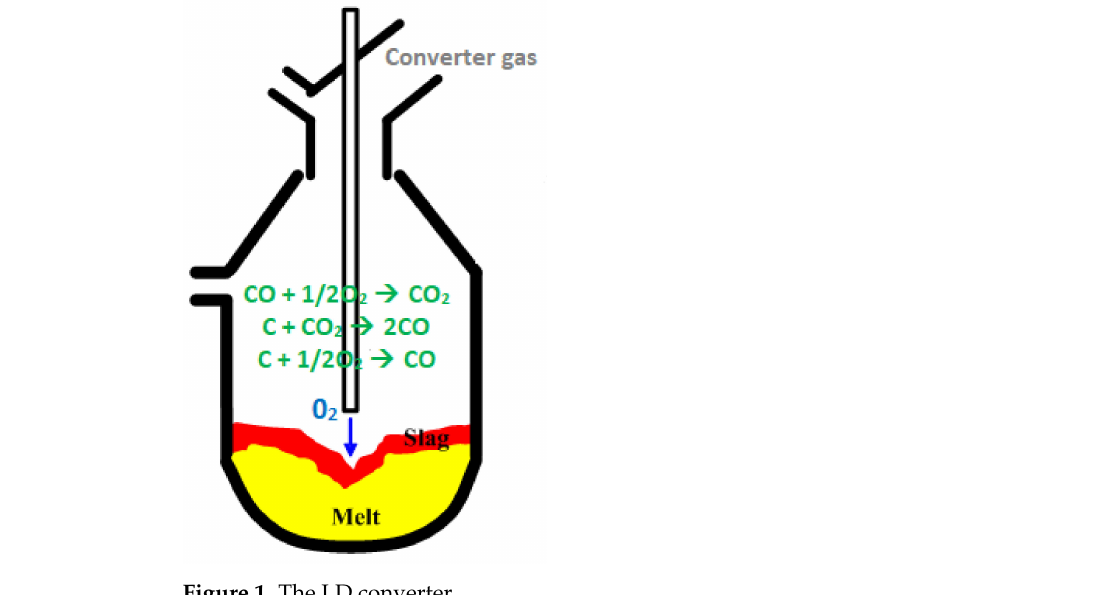
Figure 1. The LD